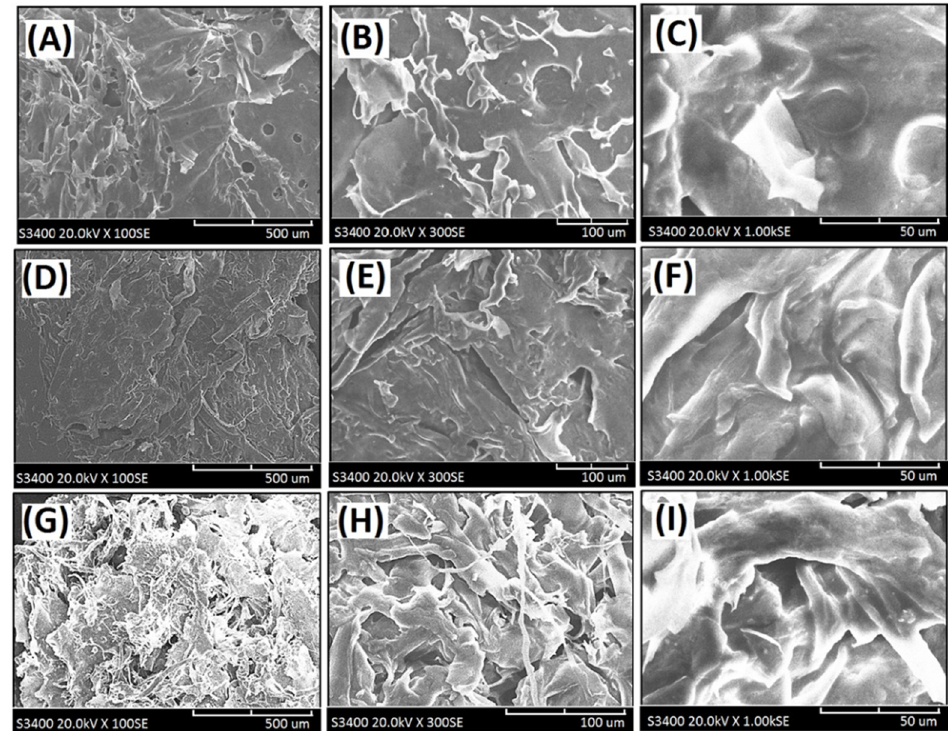
Figure 5. Scanning electron micrographs of the cross-linked composite foam materials with decel- lularized elastic cartilage microscaffolds: ( A ) PCFM1H (100×), ( B ) PCFM1H (300×), ( C ) PCFM1H (1000×), ( D ) PCFM2H (100×), ( E ) PCFM2H (300×), ( F ) PCFM2H (1000×), ( G ) PCFM3H (100×), ( H ) PCFM3H (300×), and ( I ) PCFM3H (1000×).